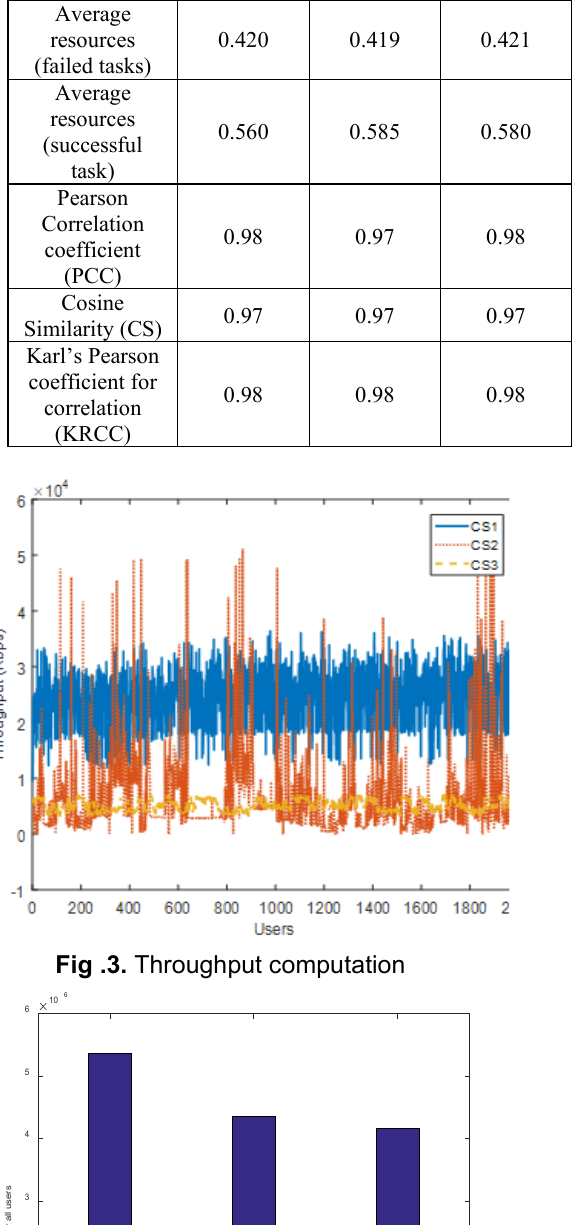
Table 2. Allocated resource analysis